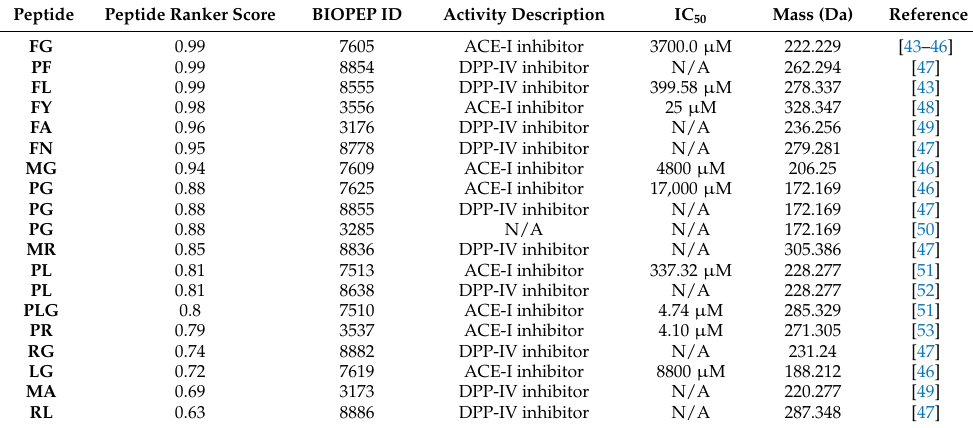
Table 3. Previously identified peptides from oat ( Avena sativa ) generated using in silico hydrolysis with papain or